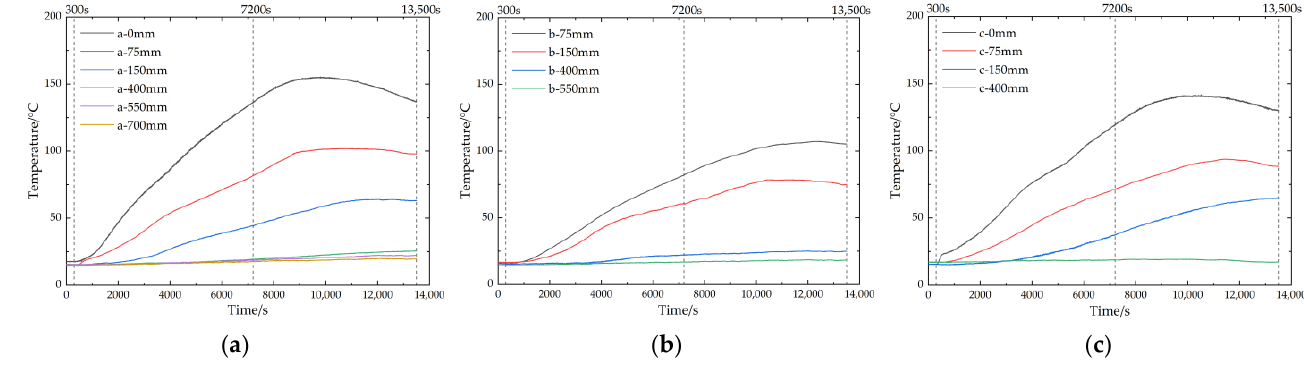
Figure 18. Temperature values of measuring points at each section under double-layer seam con- struction. ( a ) Section a; ( b ) Section b; ( c ) Section c.